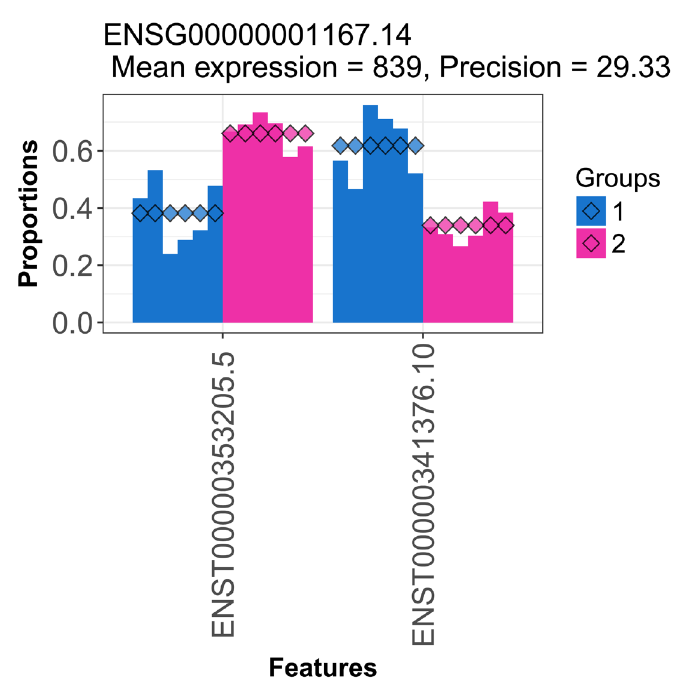
Figure 3. Estimated transcript proportions for one of the significant